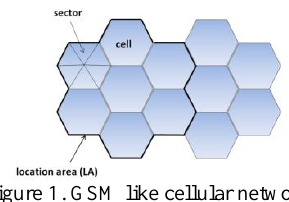
Figure 1. GSM like cellular network